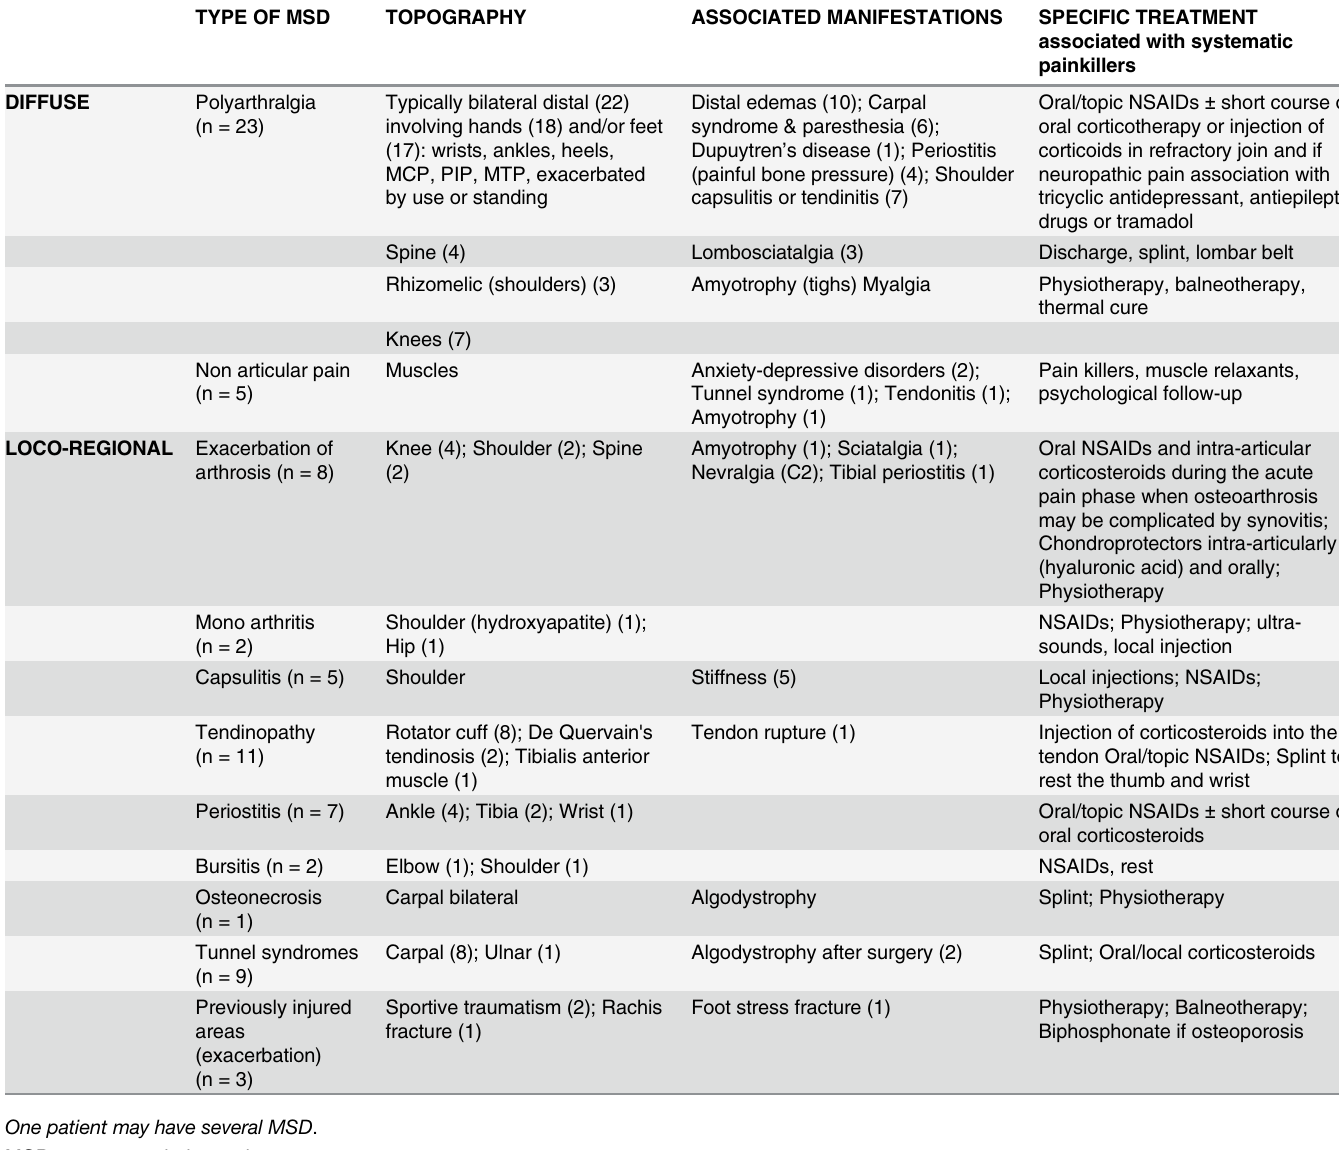
Table 5. Clinical characteristics and speci fi c treatments of patients consulting for musculoskeletal pain (multiple joint in fl ammation excluded) persisting after a con fi rmed chikungunya infection, Saint-Denis, Reunion Island, 2006 – 2012. TYPE OF